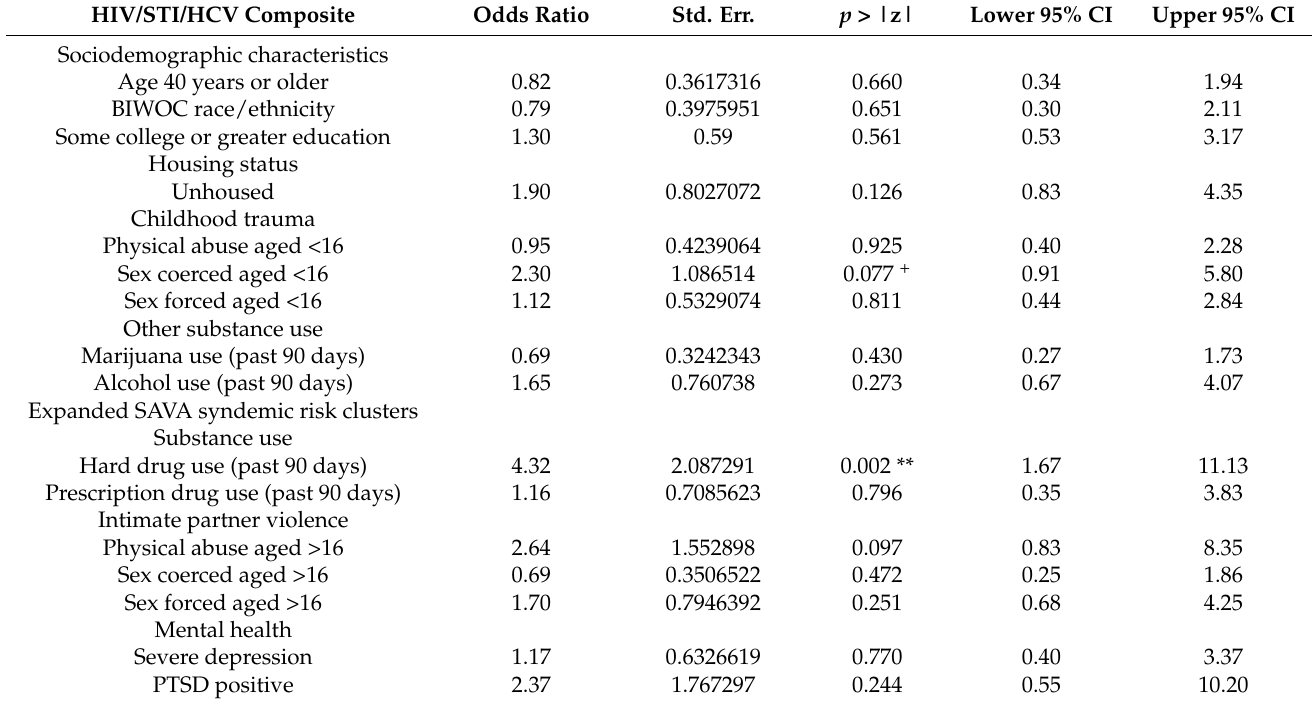
Table 3. Longitudinal multivariate logistic regression expanded SAVA syndemic risks and HIV/STI/HCV